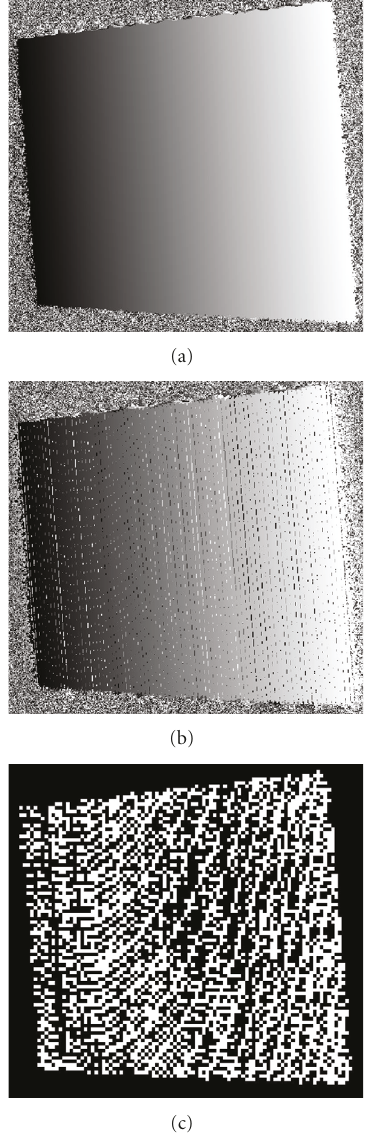
Figure 4: Appearance of the unwrapped phase map using the (a) proposed method and (b) the original G-S method; (c) shows (emphasized) in black all pixels with an incorrect unwrapped phase obtained by